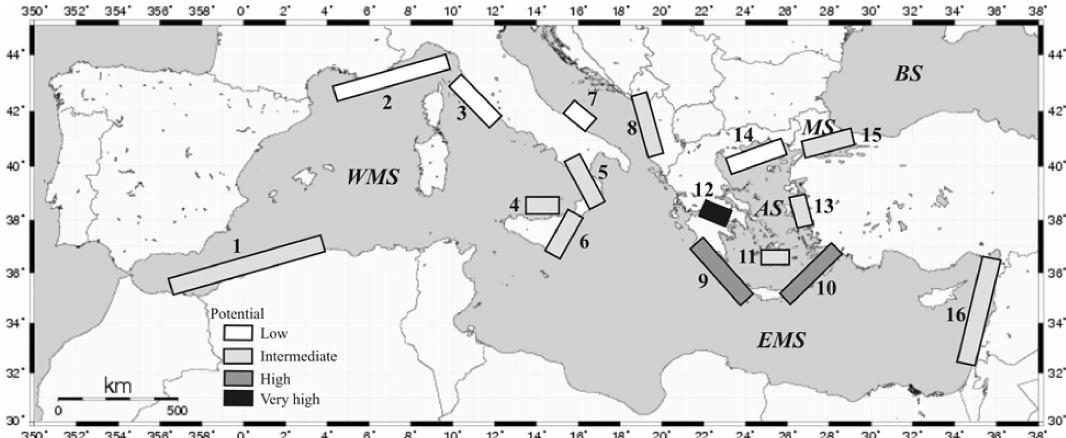
Figure 4. The tsunamigenic zones of the Mediterranean Sea and their respective tsunami potential (adopted from Papadopoulos and Fokaefs, 2005).